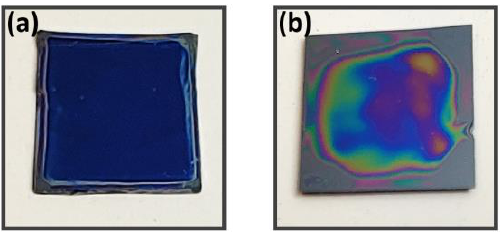
Figure 2. Pictures of two samples: ( a ) 1.2 wt.% + 25% volume of MeOH at 3k RPM with average thickness = 107 nm and Std/Ave = 2.01%; ( b ) 1.2 wt.% + 100% volume of MeOH at 1k RPM with average thickness = 327 nm and Std/Ave = 12%.